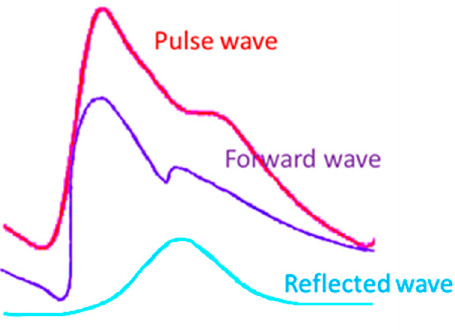
Figure 1. Red line represents the pulse wave, blue line represents the forward wave, light blue line represents the reflected wave.